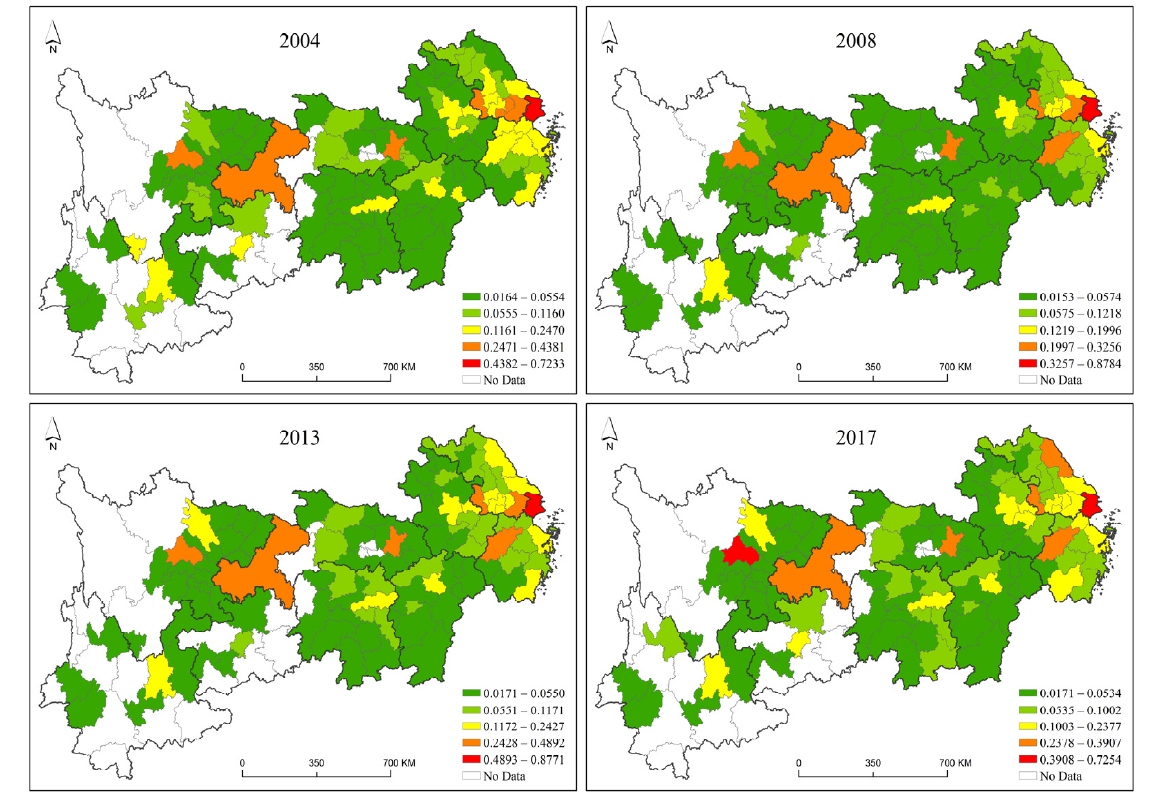
Figure 4. Spatial and Temporal Patterns of Green Development Level.